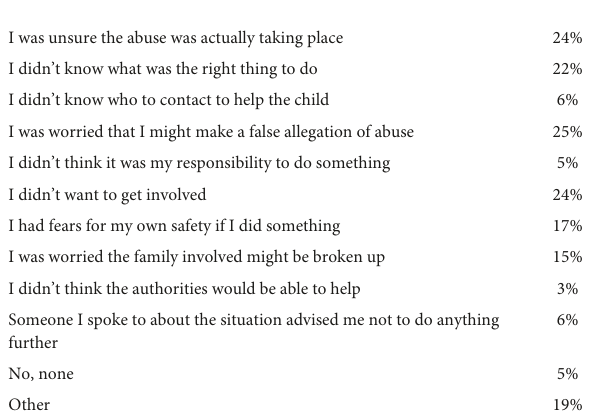
TABLE 14 Main reason for not taking